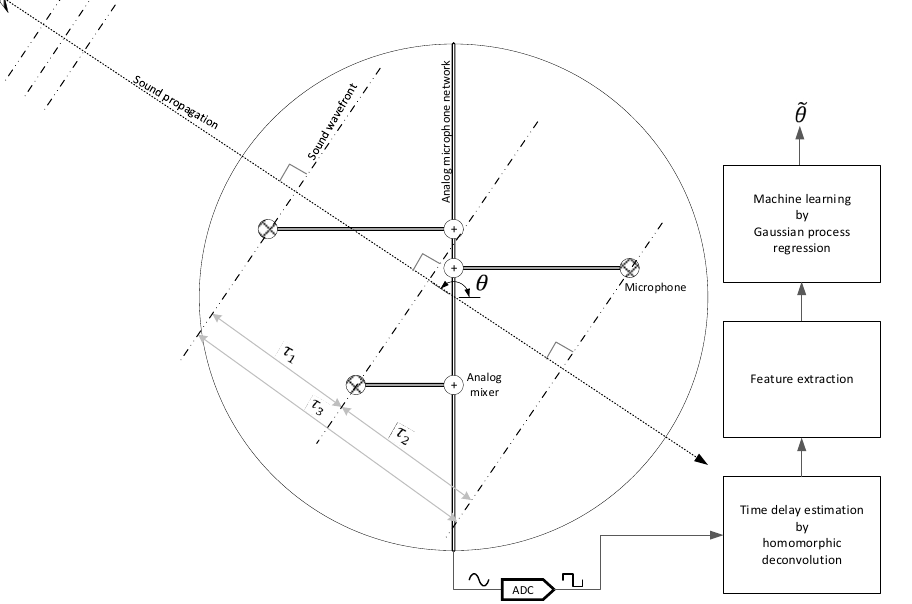
Figure 1. Functional diagram of the overall SCSSL system. The big circle indicates that the object installed three microphones with an analog microphone network. θ is the real arrival angle for the sound and (cid:101) θ is the estimated angle.